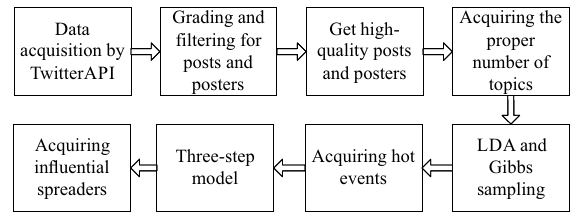
Fig. 3 Procedure of the TS-LDA model.